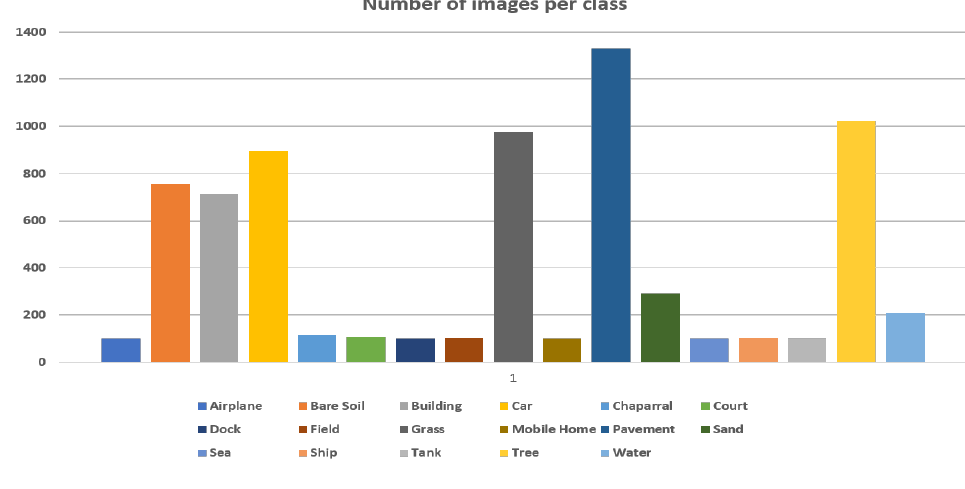
Figure 1. Distribution of number of images per class.